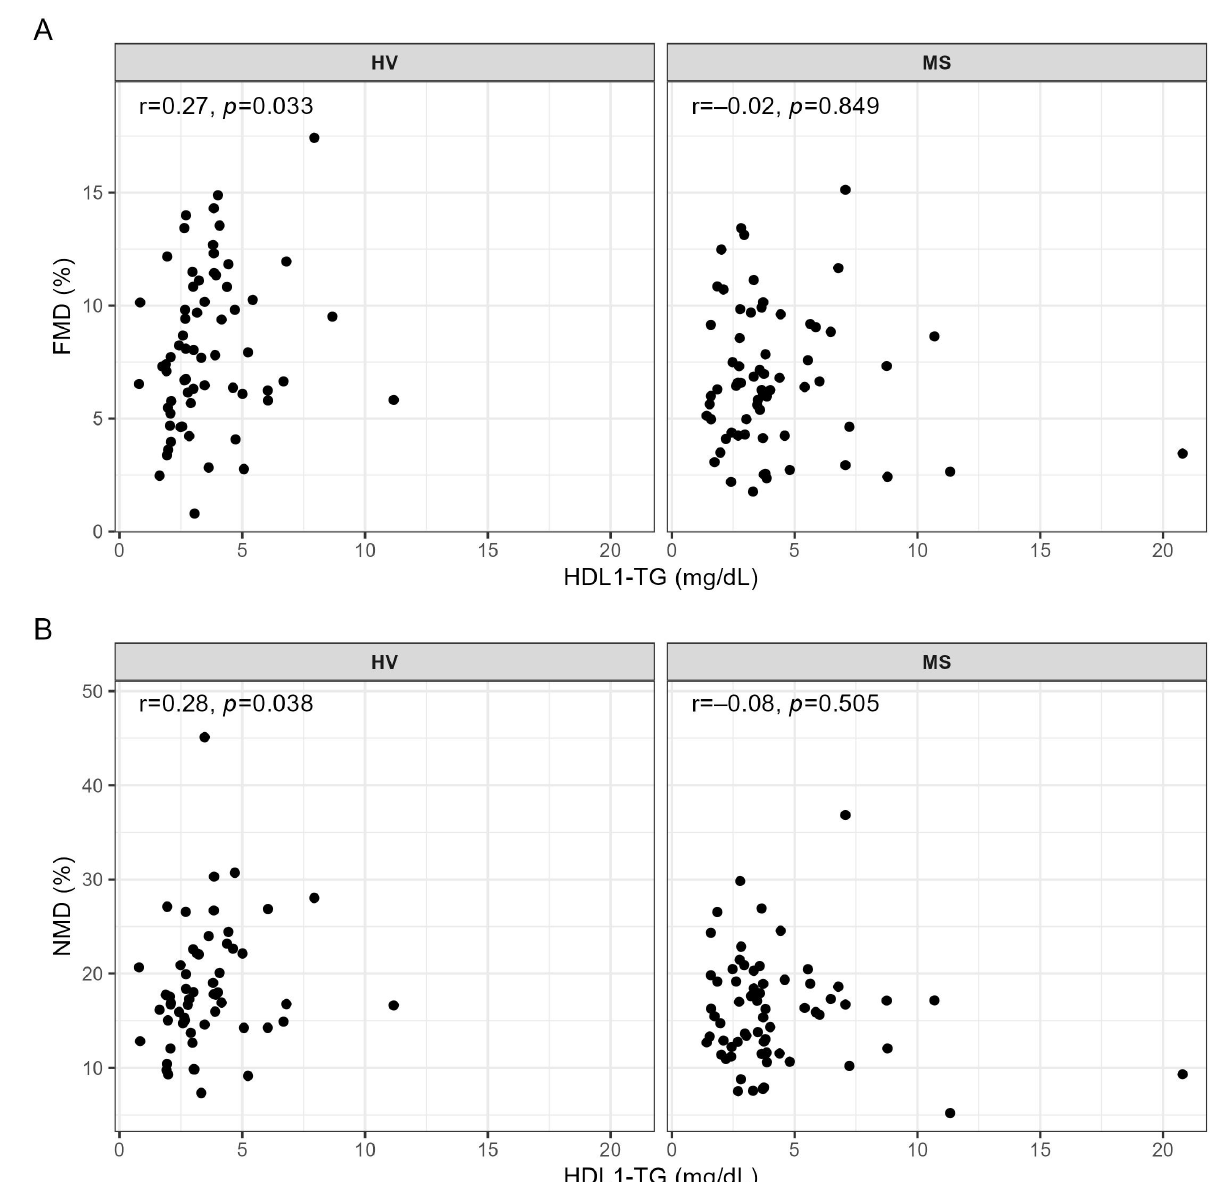
Figure 2. Correlations of HDL1-TG with ( A ) FMD and ( B ) NMD in HV and MS patients. Correlations were quantified using Spearman’s correlation coefficient. dL, deciliter; HDL, high-density lipoprotein; HV, healthy volunteer; FMD, flow-mediated dilation; mg, milligram; MS, metabolic syndrome patient; NMD, nitroglycerin-mediated dilation; r, Spearman’s correlation coefficient; TG, triglyceride.